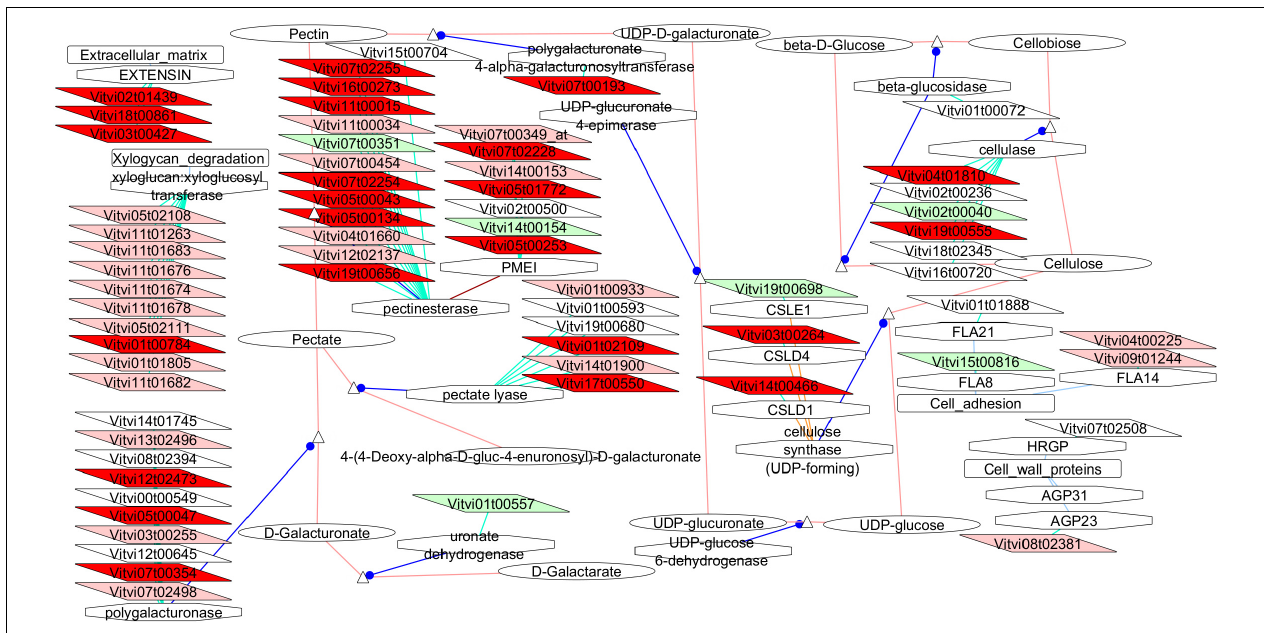
FIGURE 5 | Adapted Cytoscape VitisNet networks including transcripts differentially expressed in flowers at E-L 18–19 between VP11 and the compact clones related to cell wall metabolism. Dark red, genes over-expressed in compact clones RJ51 and VP2; light red, genes over-expressed in compact clone RJ51 vs. VP11; light green, genes over-expressed in loose clone VP11 vs. RJ51. Figure was adapted from networks 40006 from Grimplet et al. (2009), genes in white background were over-expressed in another pairwise comparison; the transcripts not differentially expressed were removed from the